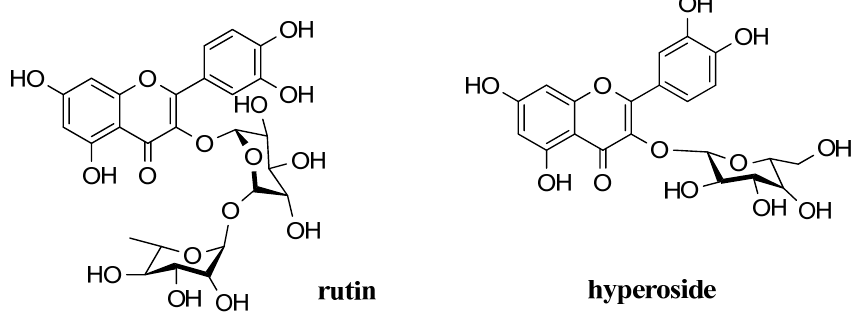
Figure 1. Structures of chosen flavonoid compounds presented in “Smoky” saskatoon